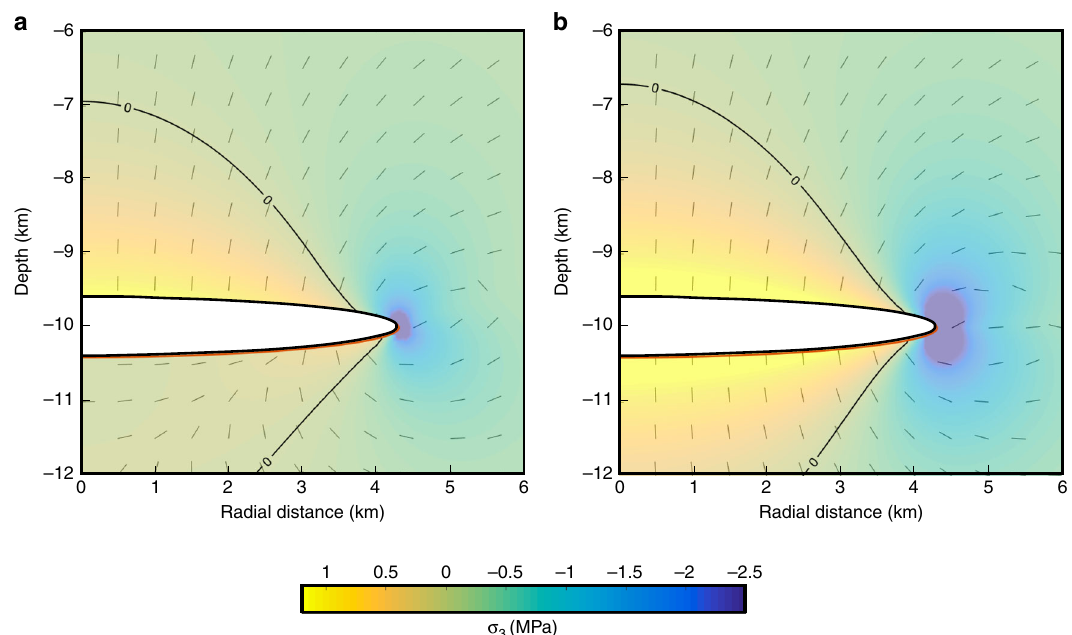
Fig. 4 Comparison of stress fi eld at magma bodies due to buoyancy and magma fl ow. a Zoom of Fig. 2b showing stress fi eld set up due to buoyancy of magma body. b Stress fi eld due to 2.5 MPa pressure increase caused by magma in fl ow, for comparison. The colour scale shows the amplitude of the minimum compressive stress (negative values for tension) and the dashes represent the direction of maximum compressive stress ( σ 1